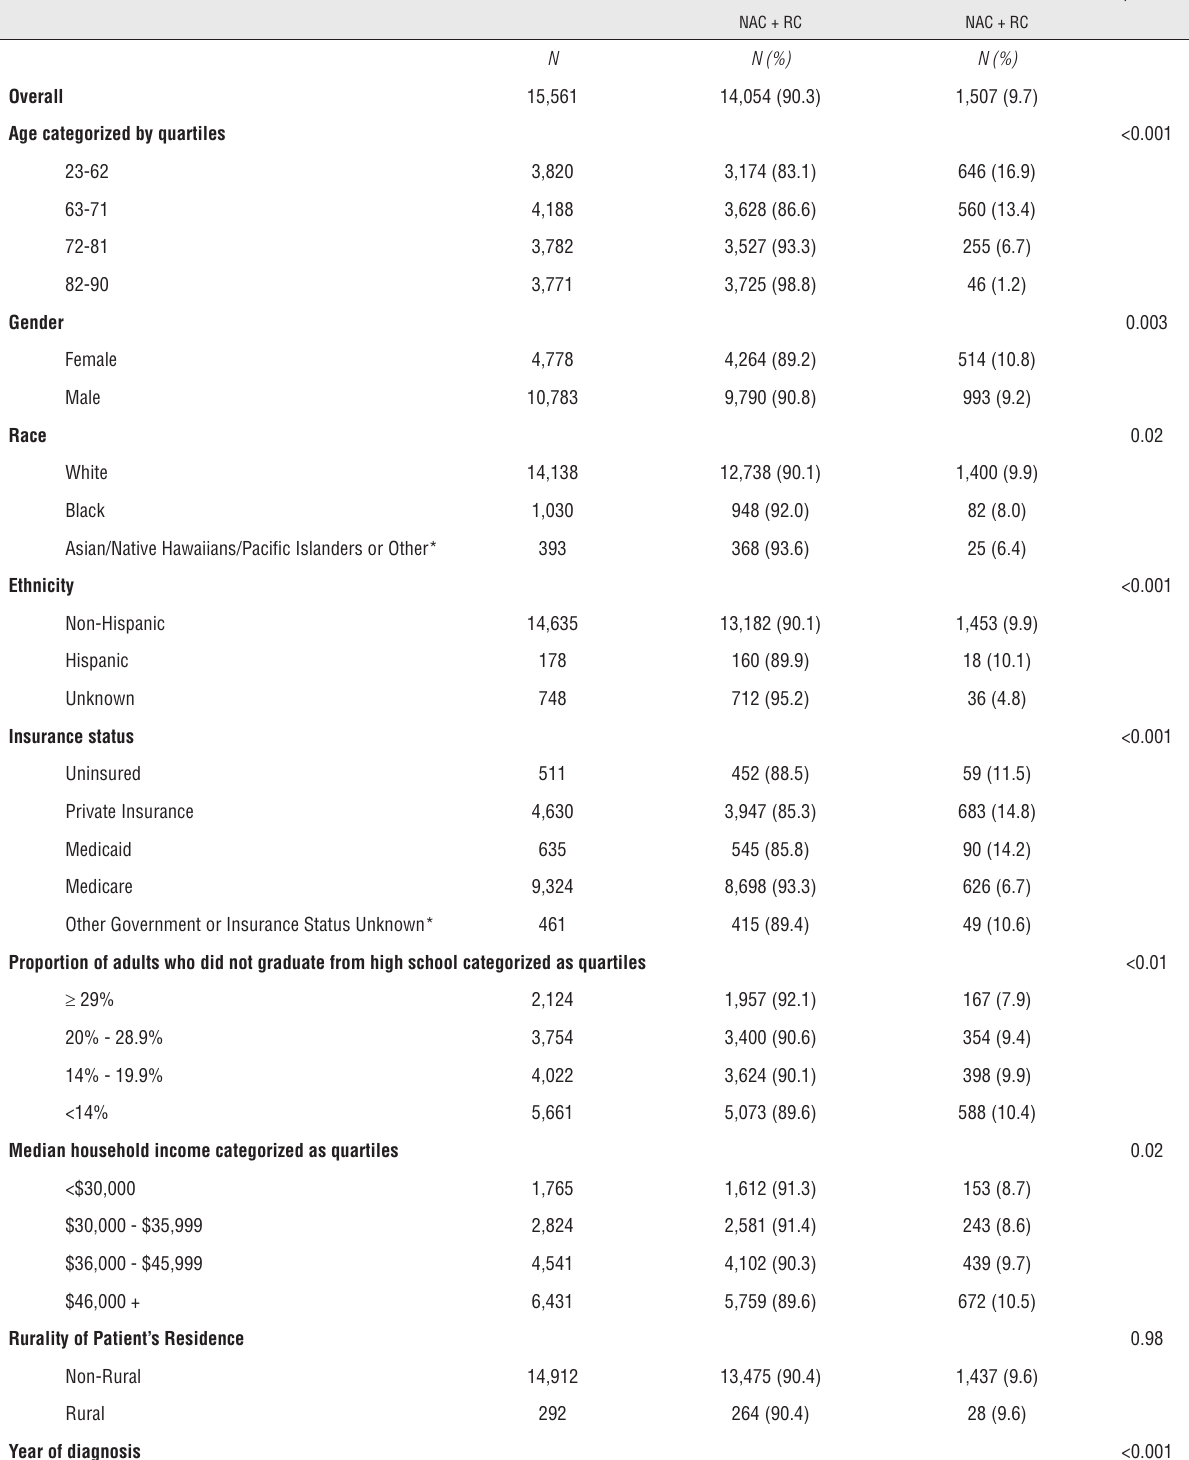
Table 2 - Characteristics by receipt NACRC for patients with MIBC and Charlson Comorbidity Index 0.